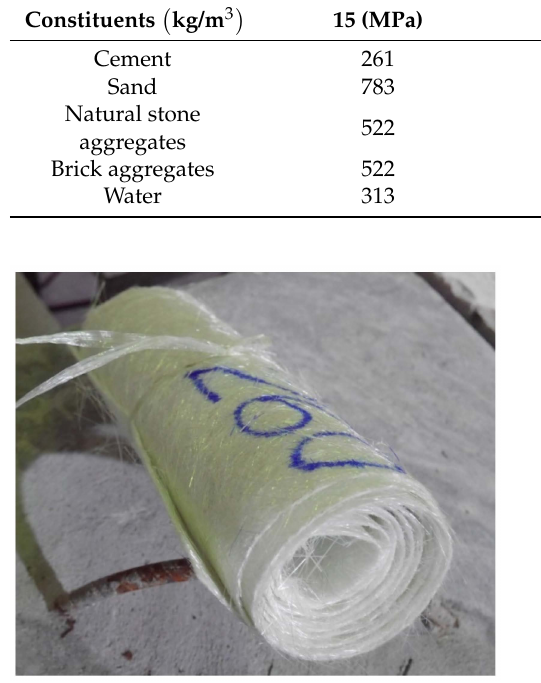
Figure 2. Typical chopped strand